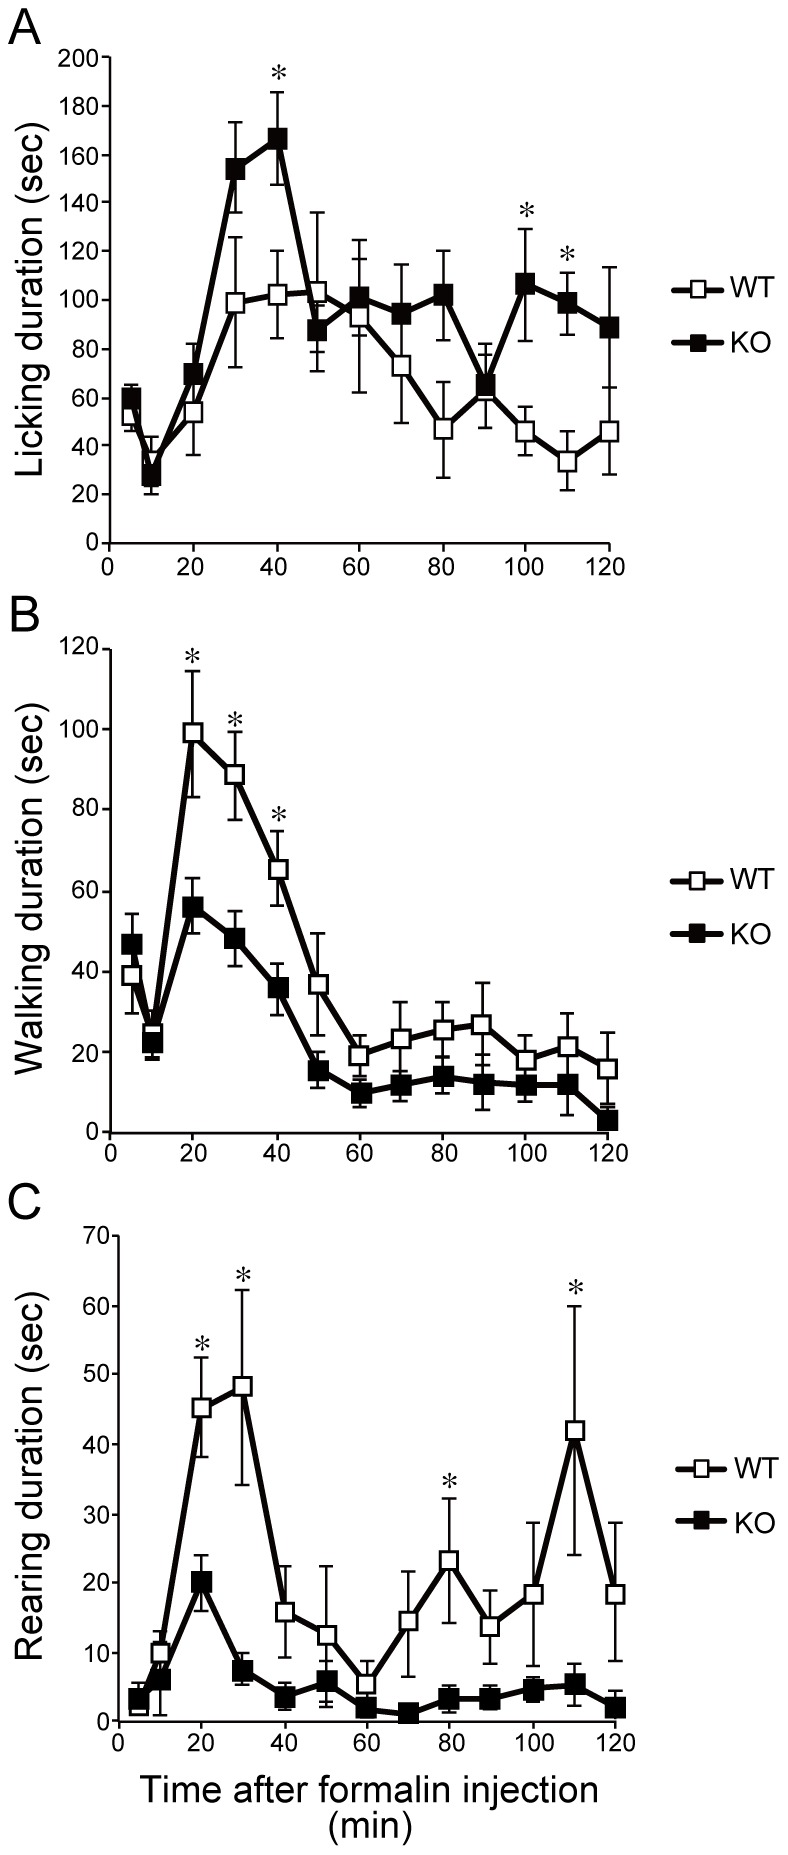
SR-KO mice show significantly enhanced pain behavior during the formalin test.Data from the SR-KO (n = 11, closed square) and WT (n = 9, opened square) mice are the durations of licking (A) of the formalin-injected paw (a pain behavior), and walking (B) and rearing (C) (nonpain behaviors) after formalin injection. Data are collected at 5 min intervals until 10 min after the formalin injection (0 min), then at 10 min intervals until the end of the observation period (120 min). (A) Formalin injected subcutaneously into the hind paw induced biphasic pain responses: an acute temporal but intense licking followed by a short pause (1–10 min; phase 1), and prolonged continuous tonic licking during the observation period (11–120 min; phase 2). There is no significant difference in licking duration between the SR-KO and WT mice in phase 1. However, the SR-KO mice showed significantly enhanced pain behavior in the early (40 min) and late (100 and 110 min) stages of phase 2. (B) In the early stage (20, 30, and 40 min) of phase 2, the WT mice walked significantly longer than the SR-KO mice. There is no significant difference in walking duration between the SR-KO and WT mice in phase 1. (C) The WT mice showed a significant increase in rearing duration in phase 2, especially in the early (20 and 30 min) and late (80 and 110 min) stages. There is no significant difference in rearing duration between the SR-KO and WT mice in phase 1. Values are the means ± SEM. Data were analyzed by two-way RM ANOVA followed by the Tukey-Kramer post-hoc test; * p<0.05.